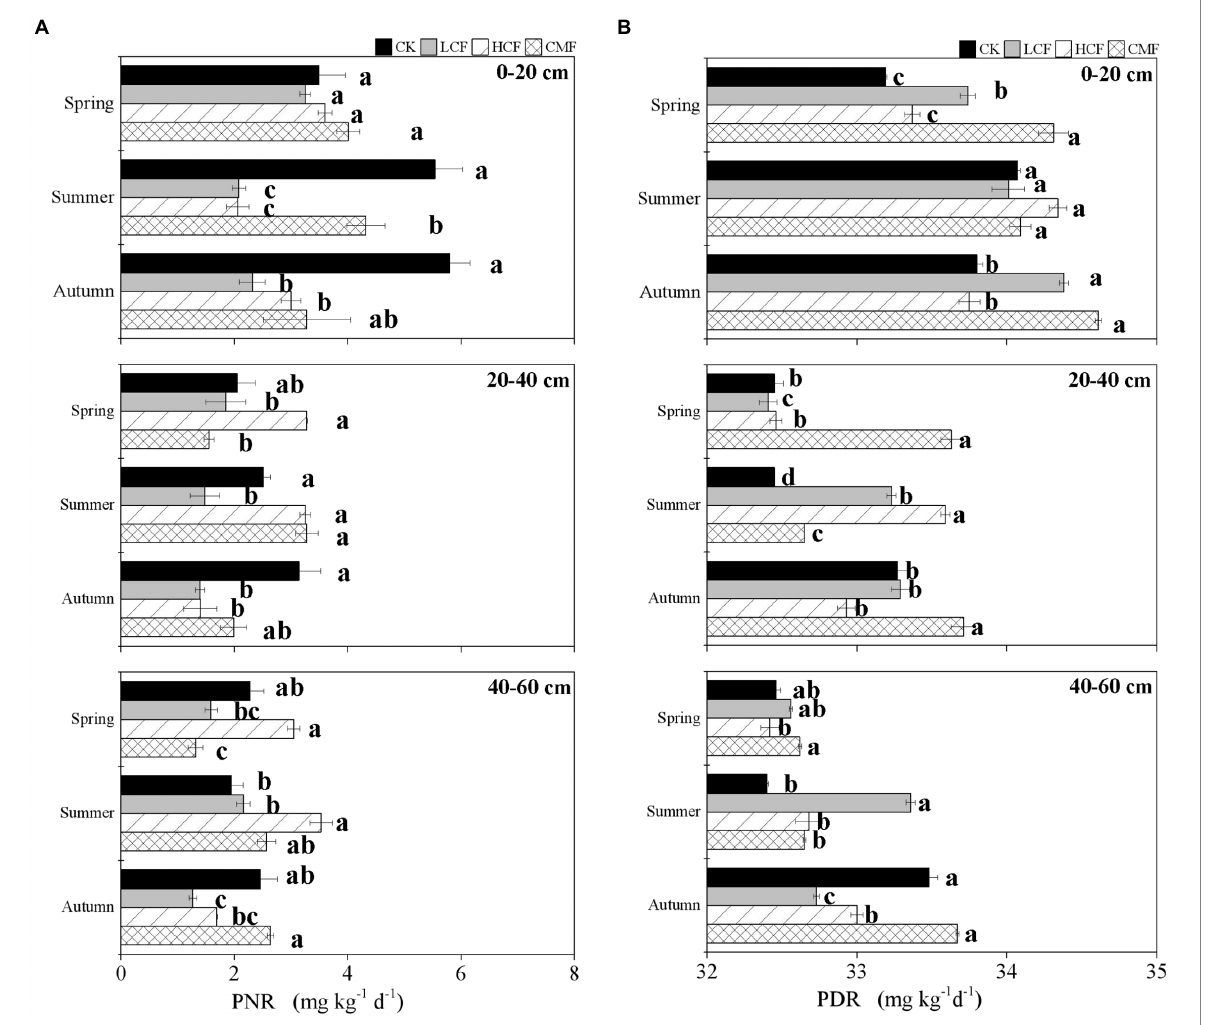
FIGURE 2 Variation in N-cycling rates as influenced by fertilization, soil horizon and season. (A) The changes of soil potential nitrification rate (PNR). (B) The changes of soil denitrification rate (PDR). The letters represent significant differences between samples ( p <